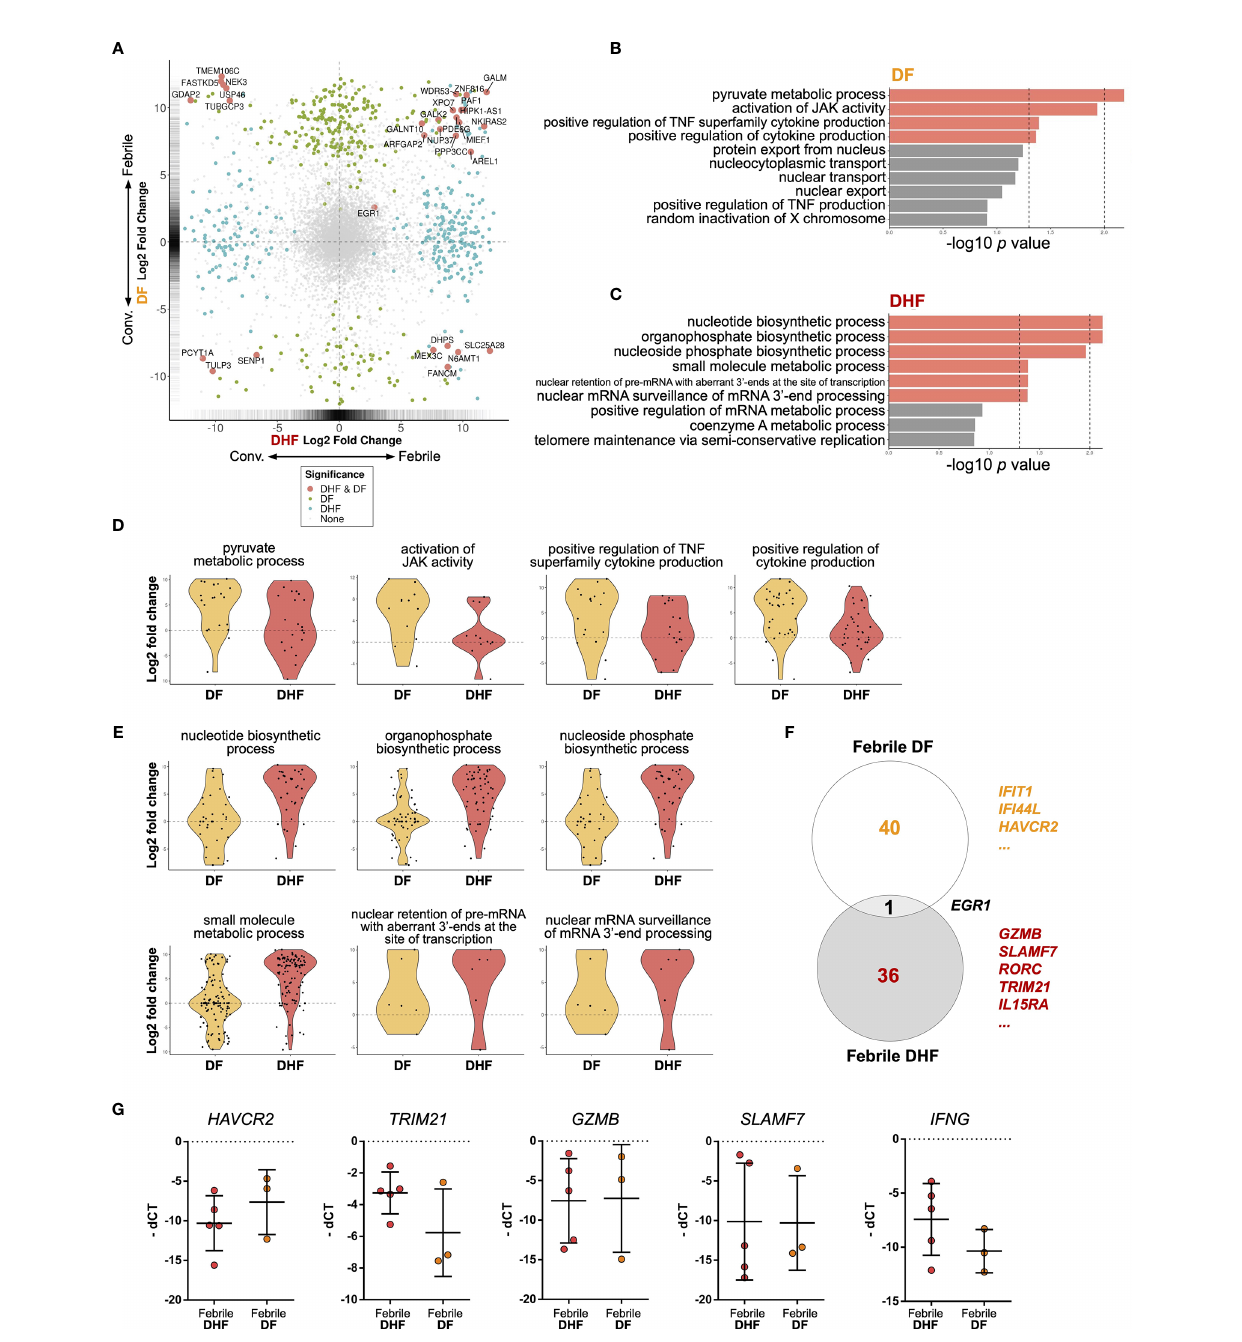
FIGURE 5 | Differential gene expression analysis of hILCs between febrile and convalescent phase of DENV infection (A) Plot comparing the fold change of DF (febrile over convalescent phase) (Y axis) to the fold change of DHF (febrile over convalescent phase) (X axis) depicts transcripts differentially expressed between disease severity and timepoint. Colored dots denote transcripts that are differentially expressed at least 2-fold higher as well as adjust p value less than 0.01. Blue or green colored dots denote differentially expressed in DF or DHF respectively. Red colored dots denote transcripts that are differentially expressed by both DF and DHF. (B, C) Bar plots show signi fi cant GO term enrichment from DE genes comparing febrile and convalescent phases in (B) DF and (C) DHF patients. (D, E) Violin plots show fold change of expression levels of matched samples between febrile and convalescent phases. Each dot represents a gene in the designated GO term by each patient. (D) show enriched GO term in DF patients and (E) shows GO term enriched in DHF patients. (F) Venn diagram shows number of differentially expressed genes in DF (febrile over convalescent phase), DHF (febrile over convalescent phase) and both after shrinkage algorithm ‘ apeglm ’ was applied. Immune- related genes are listed beside the diagram. (G) Expression levels of HAVCR2 , TRIM21 , GZMB , SLAMF7 , and IFNG by quantitative PCR (delta Ct value (dCt) = Ct value of ACTB - Ct value of interested gene). Bar showing median ±